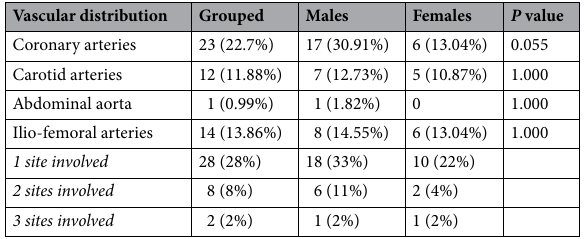
Table 2. Distribution of plaques amongst the various vascular territories stratified by gender. P value represents the statistical difference between males and females at each vascular site.